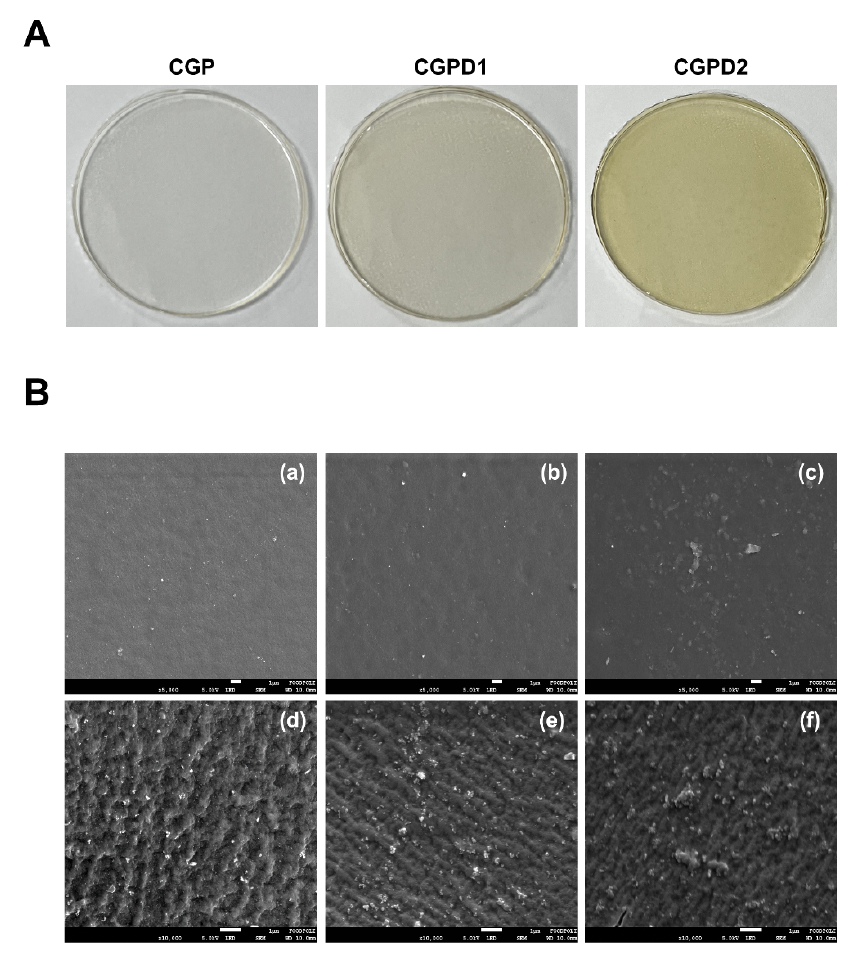
Figure 1. Visual appearance ( A ) and SEM images ( B ) of the surface ( a – c ) and cross ‐ section ( d – f ) of films: ( a , d ) CGP; ( b , e ) CGPD1; ( c , f )